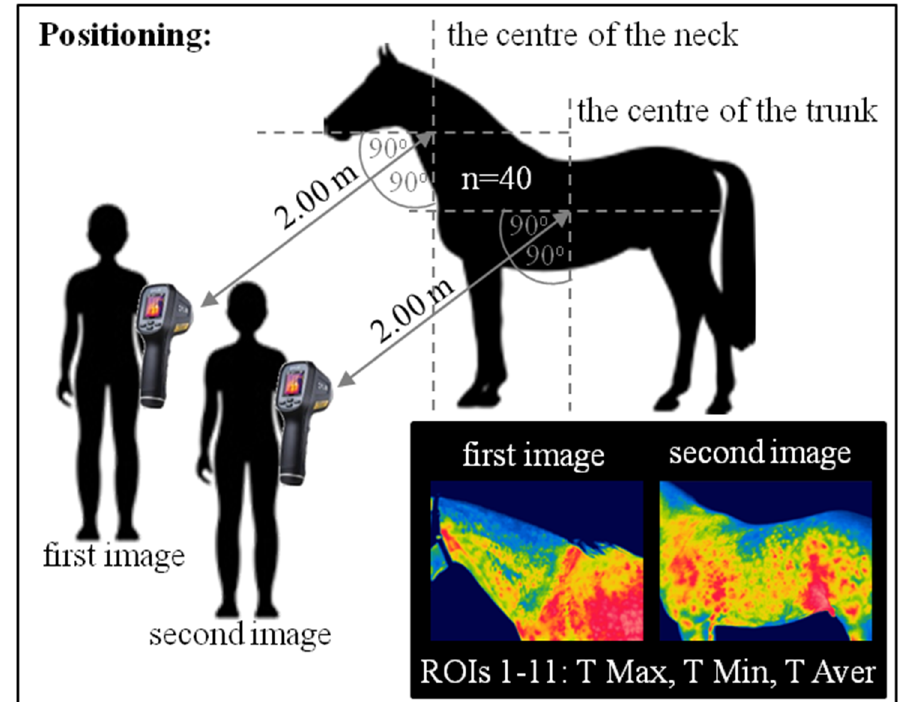
Figure 1. The procedure of the thermographic data collection. The measurements were repeated three times: Before exercise, immediately after exercise, and 30 min after exercise. Two images were taken each time. In each image, 11 regions of interest (ROIs) were determined. The maximal temperature (T Max), the minimal temperature (T Min), and the average temperature (T Aver) were calculated for each of the ROIs.